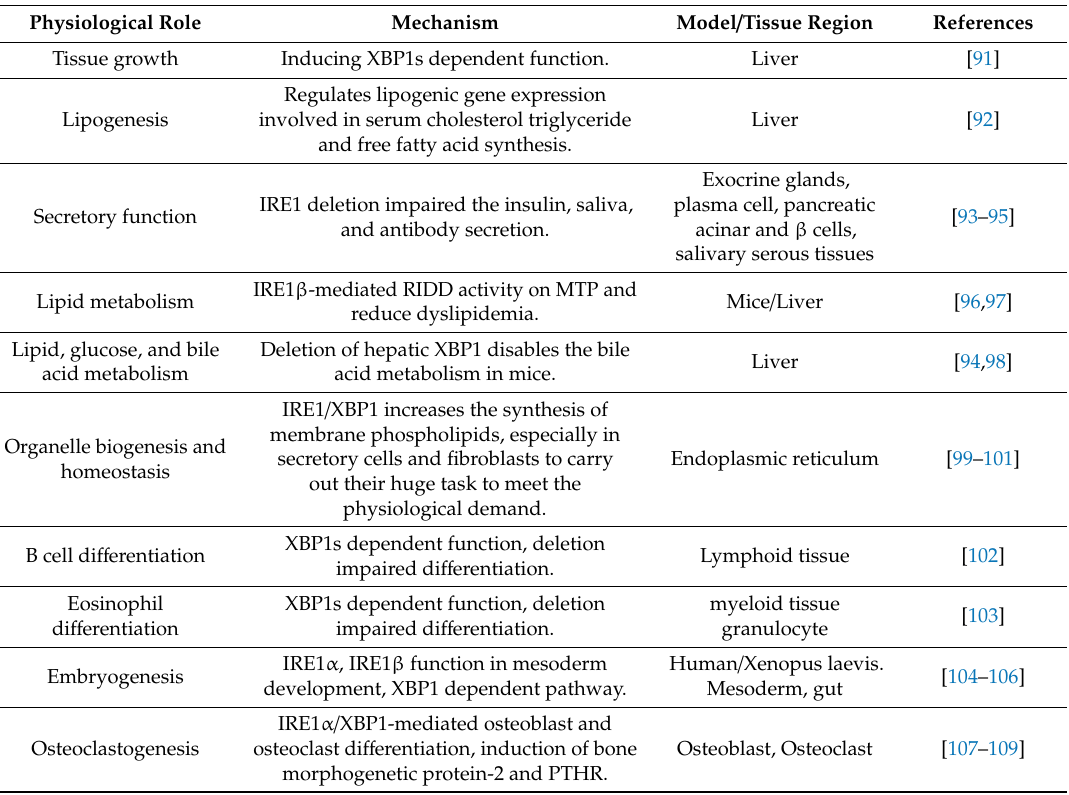
Table 1. Di ff erent functions of IRE1 α in cellular